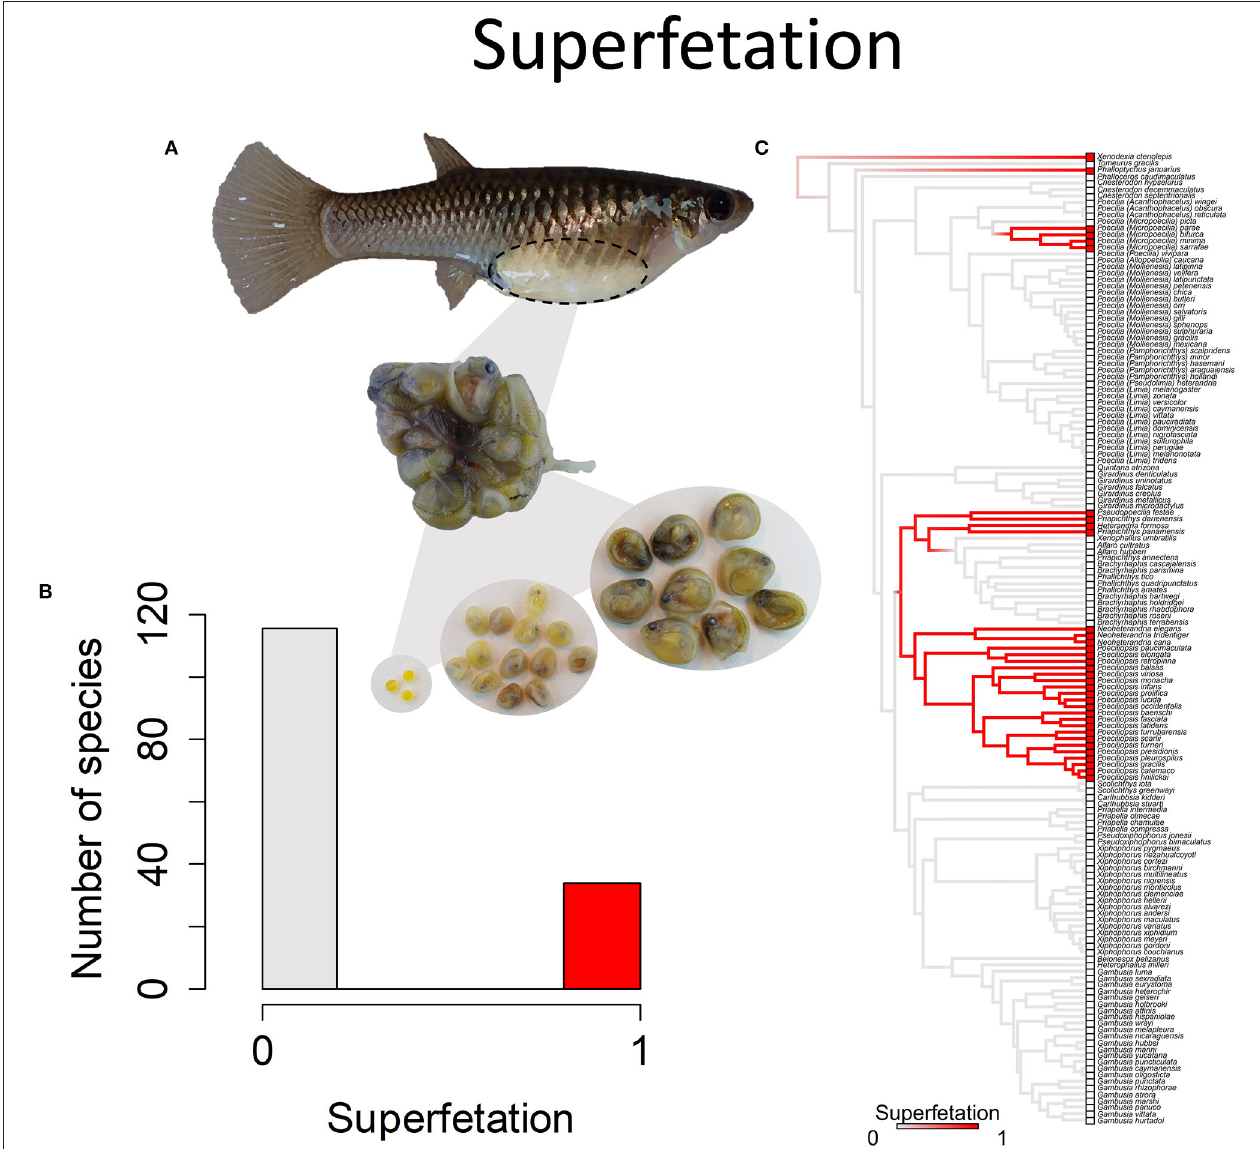
FIGURE 9 | Superfetation refers to the capacity of females to gestate more than one brood of offspring at different stages of development. (A) Poeciliopsis retropinna exhibits superfetation (Hagmayer et al., 2018, Hagmayer et al., 2020). Broods at different stages of development (pictured) are simultaneously gestated in the ovary. (B) Frequency histogram of presence or absence of superfetation ( n = 150). (C) Ancestral state reconstruction of superfetation as a binary character was performed using stochastic character mapping in the R package phytools. Branch colors represent posterior densities of edge states based on 1000 stochastic character maps of each reconstruction. The phylogeny tips depict a binary categorization of courtship (i.e., absence vs. presence). Figure redrawn after Furness et al. (2019). The most likely ancestral state of the family is the absence of superfetation, a pattern which becomes clearer with the inclusion of additional outgroup taxa (Furness et al.,